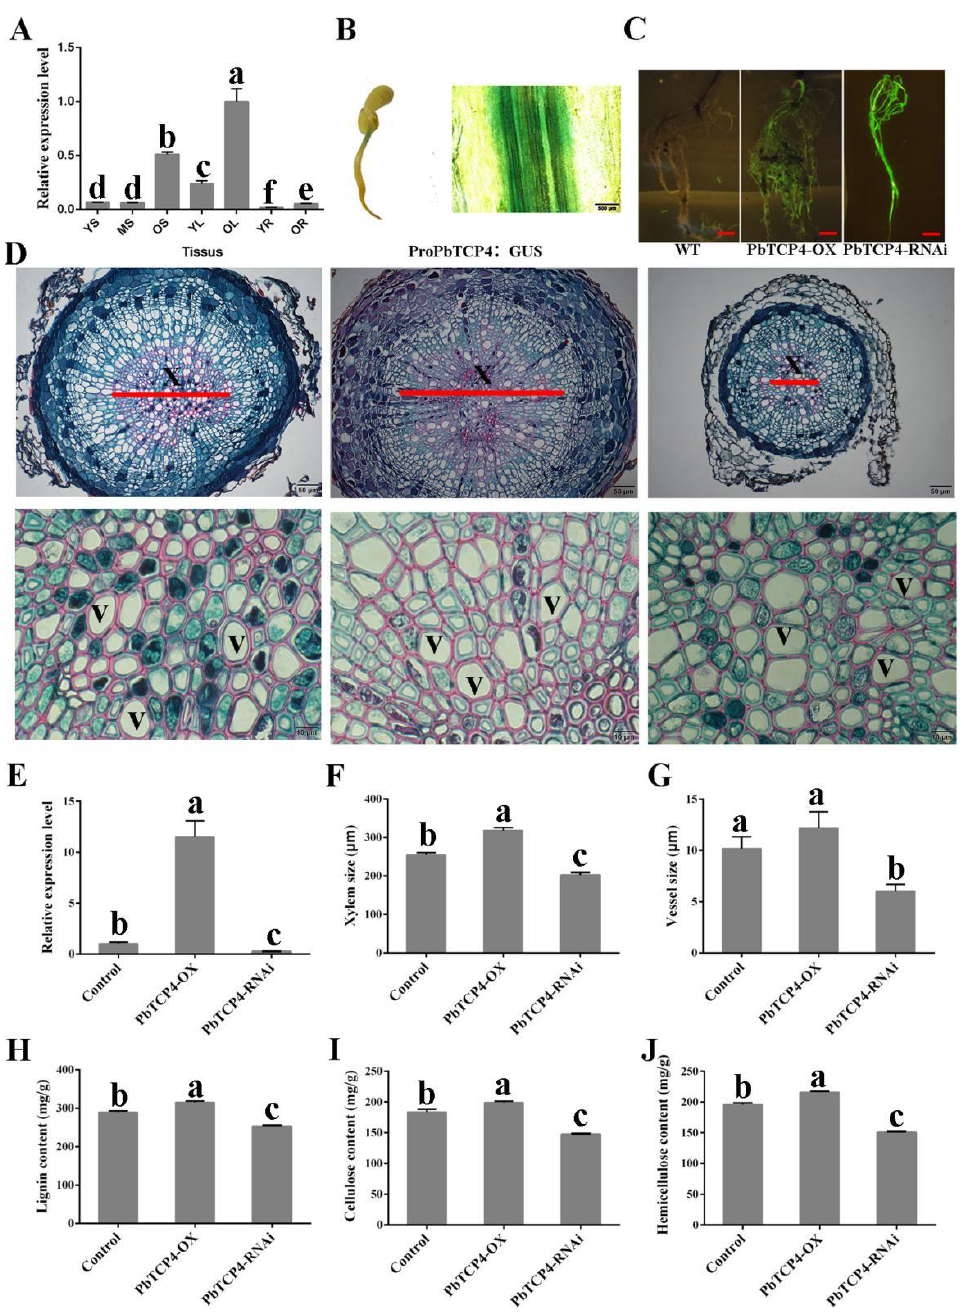
Figure 4. PbTCP4 promoted xylem development in transgenic pear roots. ( A ) Expression levels of PbTCP4 in different tissues and developmental stages. YL, young stem; ML, middle stem; OL, old stem; YL, young leaf; OL, old leaf; YR, young root; OR, old root. Data are shown as means ± SD ( n = 3). ( B ) Activity of the PbTCP4 promoter in pear vascular tissue. ( C ) The growth phenotypes and green fluorescence detection of two-month-old PbTCP4 overexpression and silencing pear roots. Bars, 2 cm. ( D ) Cross sections of roots from pear stained with safranin O and fast green. X, xylem; V, vessel. Bars, 50 µm and 10 µm. ( E ) Relative expression of PbTCP4 in transgenic pear roots. Data are shown as means ± SD ( n = 3). ( F ) Xylem size of PbTCP4 overexpression and silencing pear roots. ( G ) Vessel size of PbTCP4 overexpression and silencing pear roots. ( H – J ) The Lignin, cellulose and hemicellulose contents of transgenic roots. Data are shown as means ± SD ( n = 3). Different letters denote statistical significance ( p <